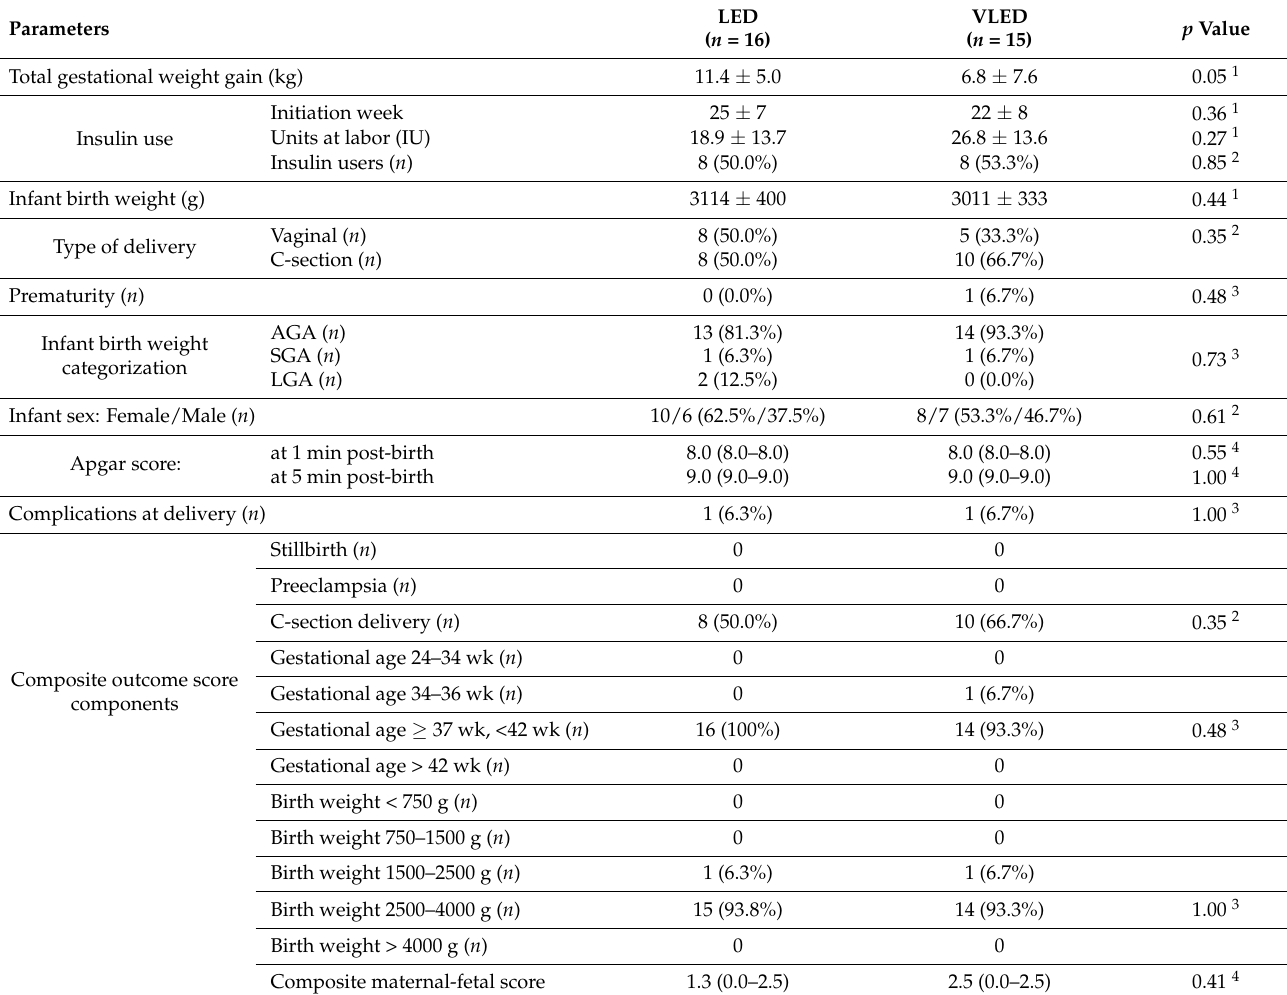
Table 3. Maternal, obstetrical and infant outcomes between the two dietary intervention arms (presented as median and IQR or n ,